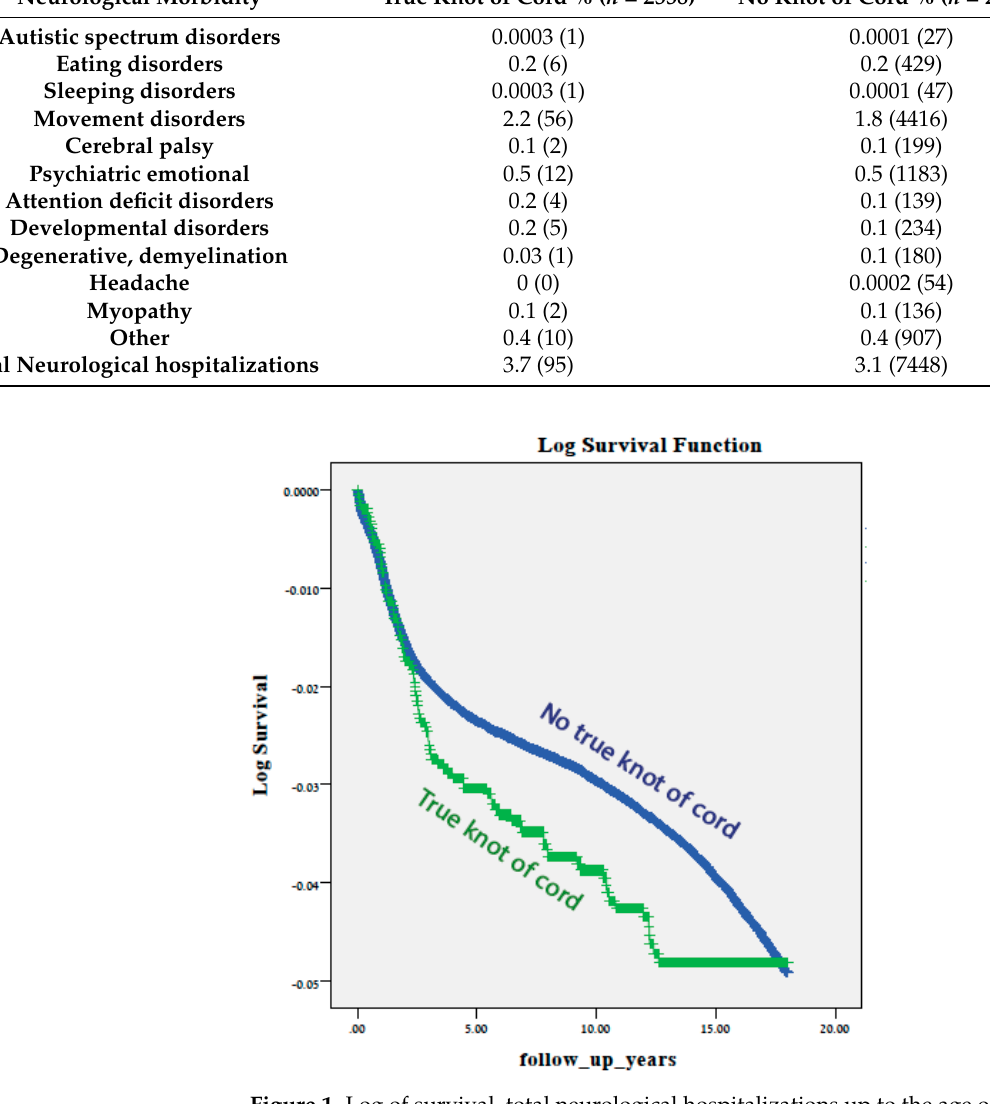
Figure 1. Log of survival, total neurological hospitalizations up to the age of 18 years by presence or absence of true knot of cord * (* log rank test p = 0.120).